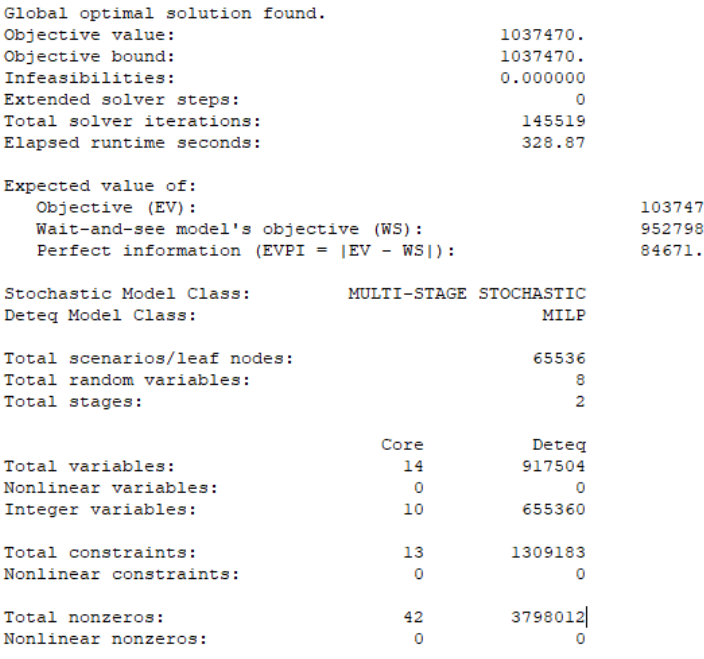
Figure A1. Example of report solution for Model-IIb, developed in LINGO 19.0.